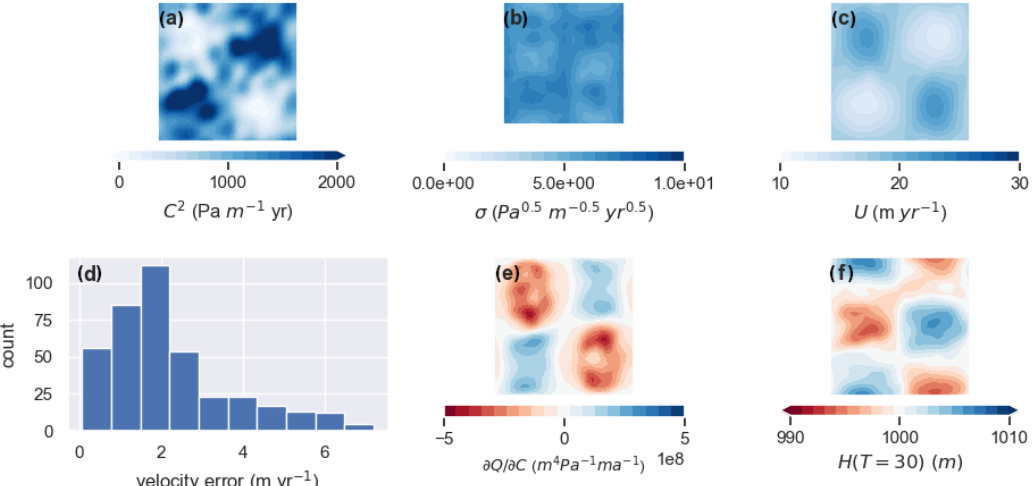
Figure 2. Results of the control method inversion with γ = 50. (a) The recovered basal traction C 2 . (b) The pointwise standard deviation of the sliding parameter C . (c) The surface speed associated with the inverted C . (d) Histogram of model–data velocity misfit (where misfit is the 2-norm of the difference of observed and modeled velocity). (e) The sensitivity of Q IS 30 years of time stepping.